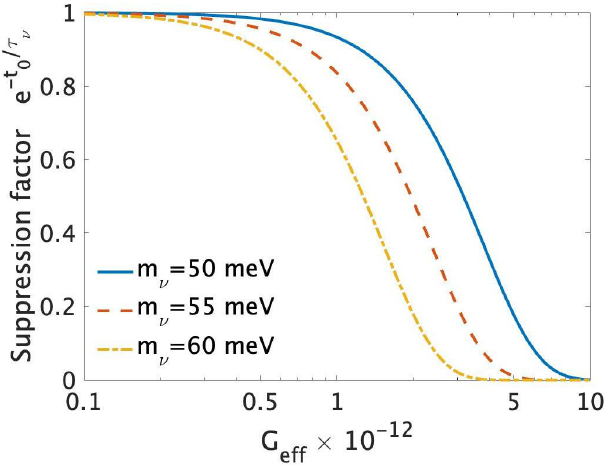
in the case of i